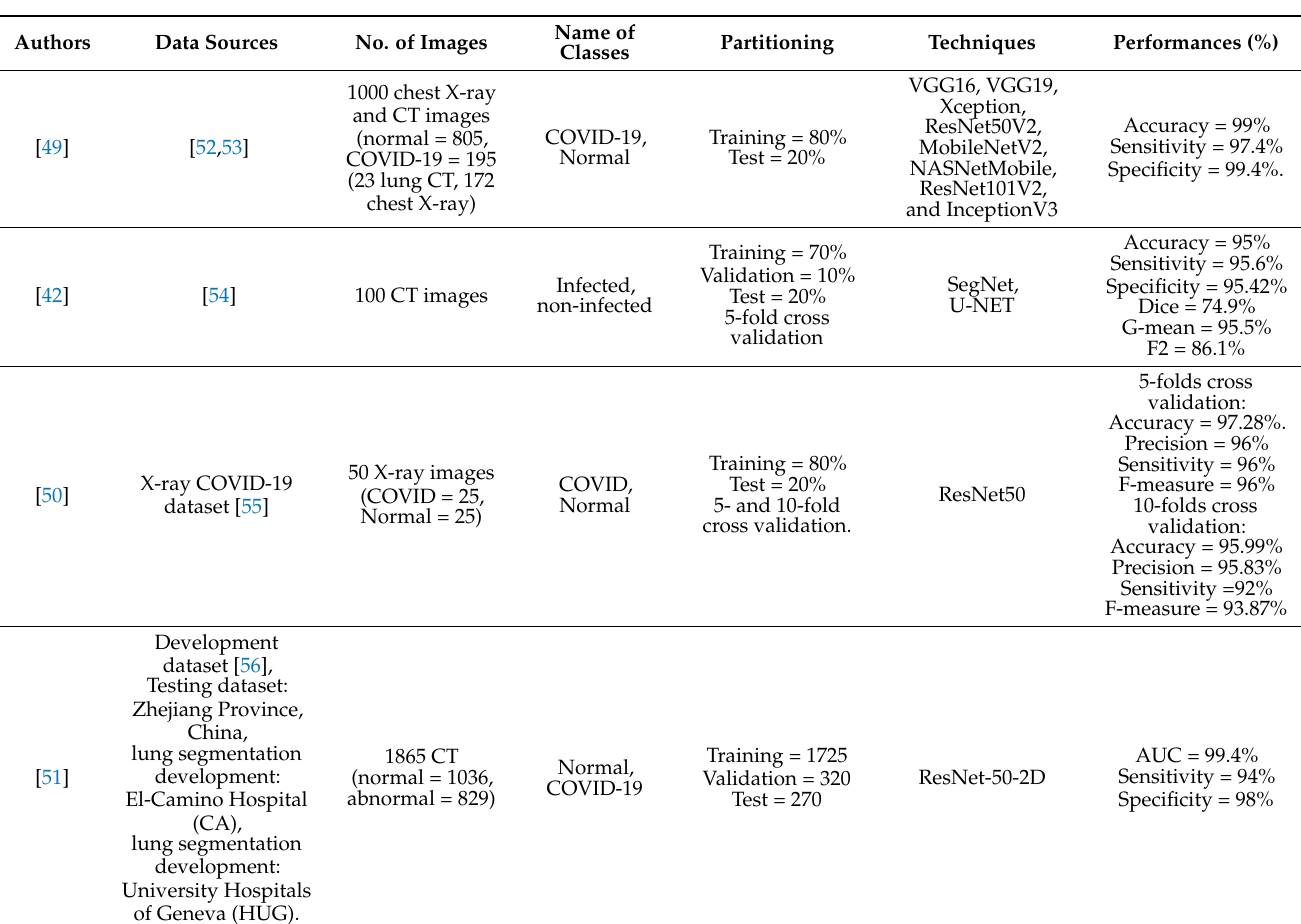
Table 5. COVID-19 binary classification using a deep learning-based pre-trained model and deep transfer